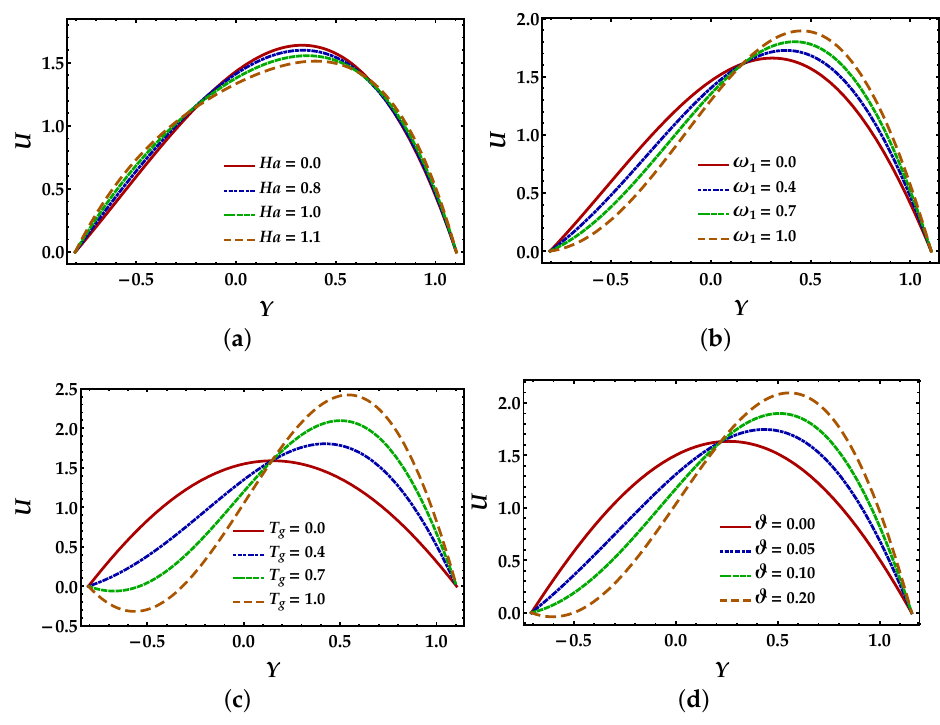
Figure 2. Velocity curves against multiple values of different parameters. ( a ) Ha , ( b ) ω 1 , ( c ) T g , ( d ) ϑ